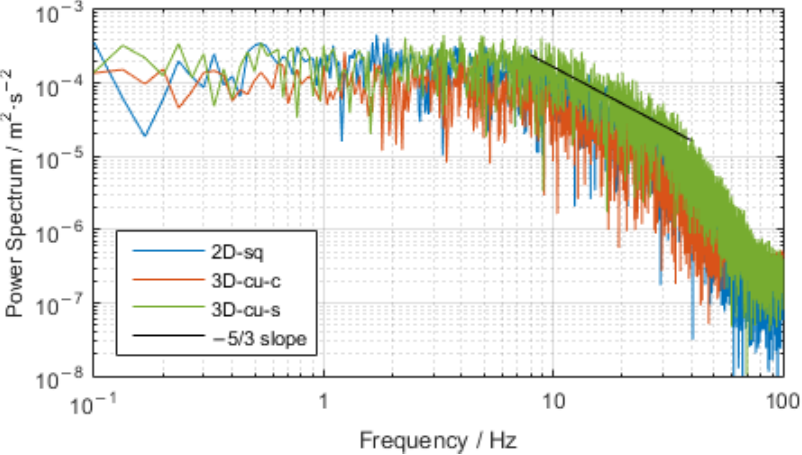
Figure 12. Power spectrum of shear stress at type B points. The power function F ( f ) added from low frequency to high frequency represents the accumulation of the shear stress energy from large scale vortices to small-scale vortices, and its maximum is the total energy of the shear stress temporal signal. In Figure 13, the frequency f is replaced with characteristic length scale L v , and the curves represent the accumulation of the shear stress signal energy from the largest scale to the smallest scale.